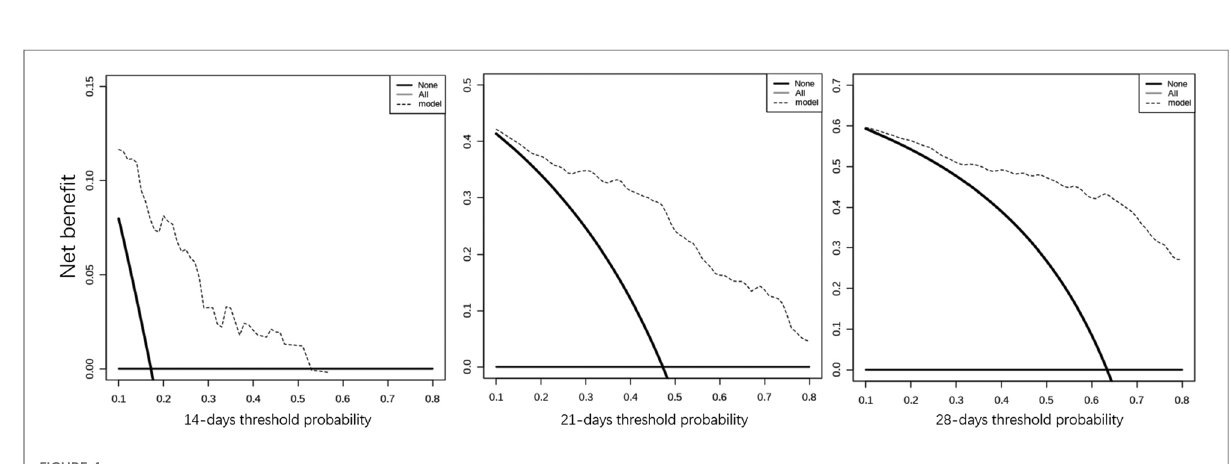
FIGURE 4 The decision curves of the nomogram in week 2, week 3 and week